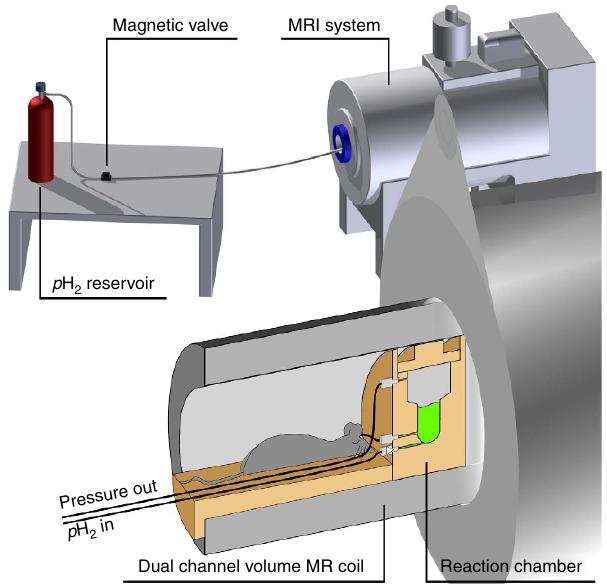
Figure 2 | HP without a polarizer: Schematic view of the experimental setup, where the HP-tracer is produced in situ within the MRI close to the application site. The essential components comprise the reaction chamber, valves, tubing, p H 2 and the MRI system. The latter is used to transfer the spin order and to detect the hyperpolarized signal.